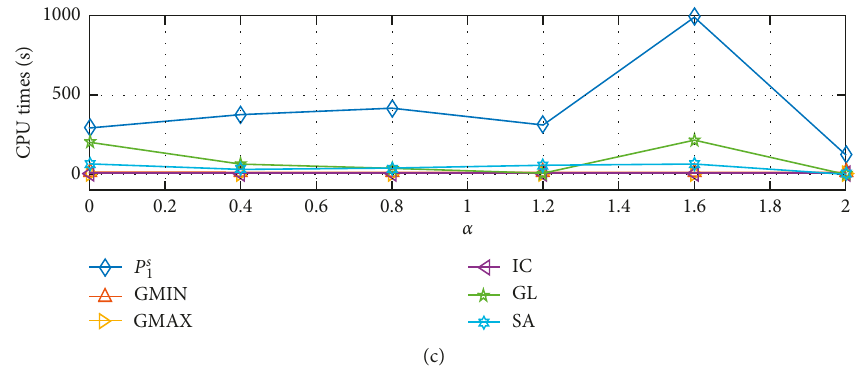
Figure 2: (a) Upper bounds and optimal solutions, (b) number of facilities, and (c) CPU times in seconds for the instance #11 in Table 1 while varying α ∈ [ 0 ; 2 ] and using a radial coverage value of 0.2 km.